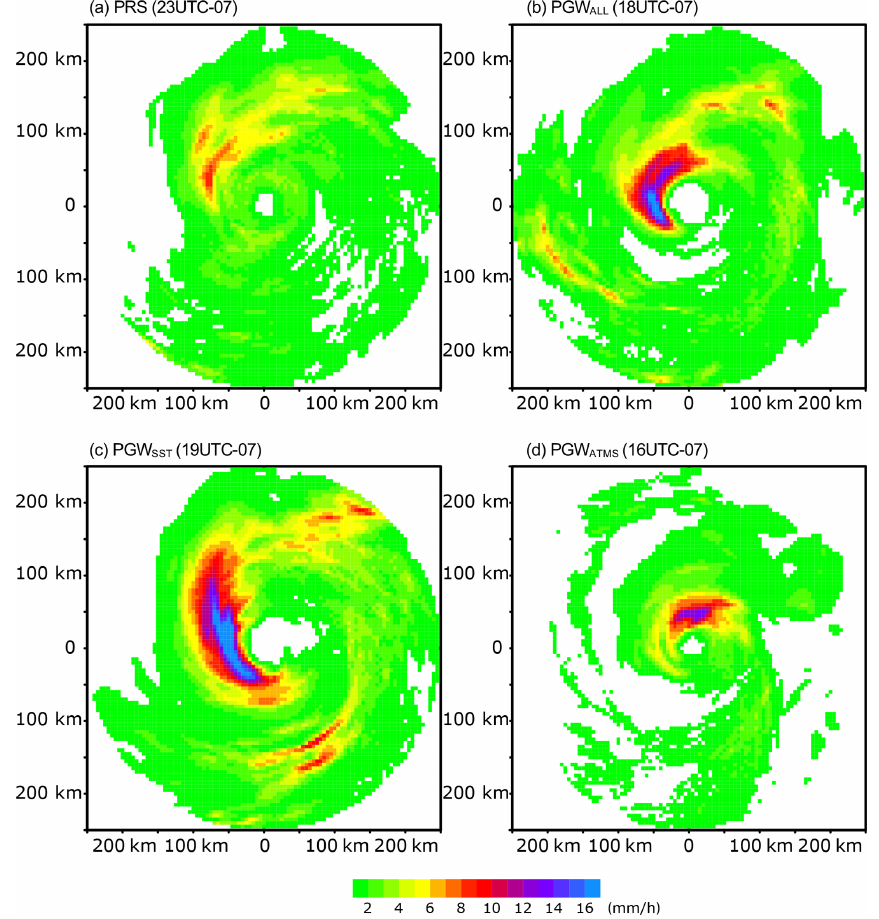
Figure 10. Precipitation during its maximum (referring to Fig. 6c) for (a) PRS, (b) PGW ALL , (c) PGW SST , and (d) PGW ATMS around the cyclone